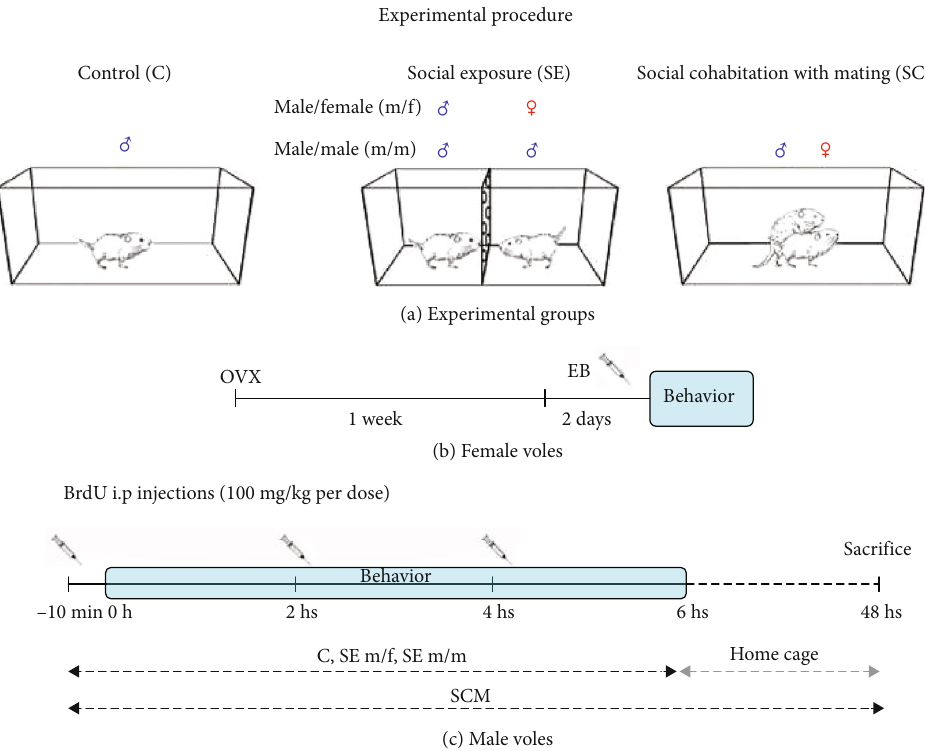
Figure 1: Schematic diagram of the experimental procedure. (a) Experimental conditions for the control (C), social exposure to a female (SE m/f), social exposure to a male (SE m/m), and social cohabitation with mating (SCM) groups. (b) Adult female voles were bilaterally ovariectomized, and after one week of recovery, they were treated with estradiol benzoate to induce sexual receptivity. (c) To visualize the new cells, adult male voles were injected with 5-bromo-2 ′ -deoxyuridine (BrdU) three times during the sexual behavior tests and were sacri fi ced 48 h after completing the tests. OVX: bilateral ovariectomy; EB: estradiol